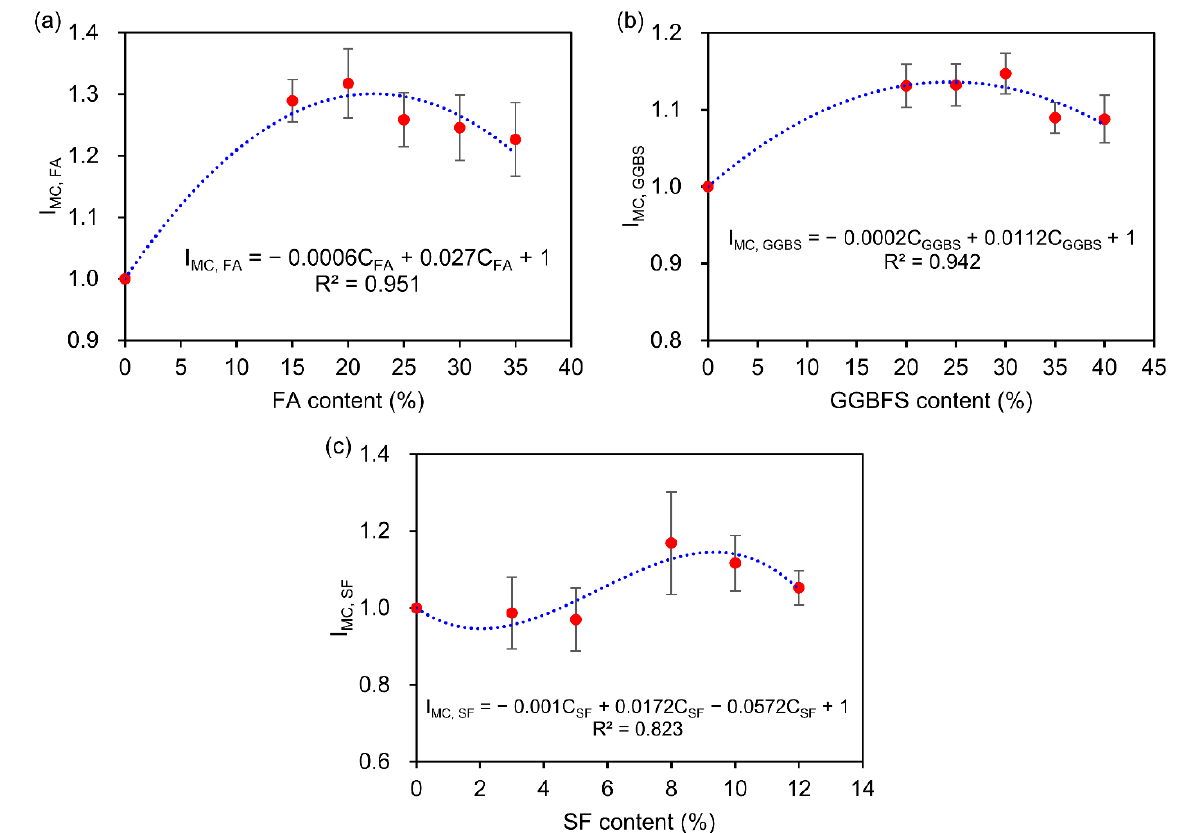
Figure 5. Effect of the mineral admixture content on DRC: ( a ) FA content; ( b ) GGBS content; ( c ) SF content.